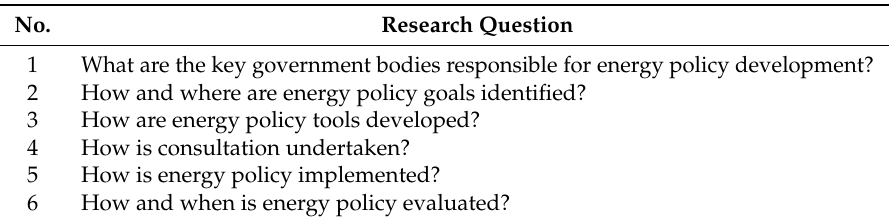
Table 2. Governance and energy policy making questions.